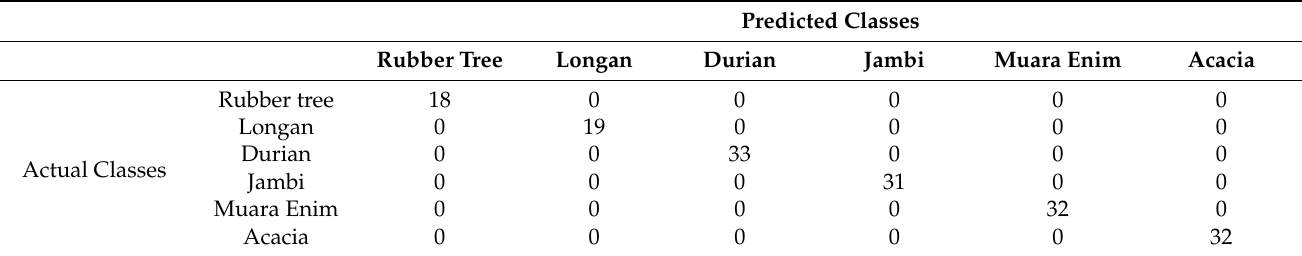
Table 3. Confusion matrix of for SIMCA prediction result using prediction sample sets.